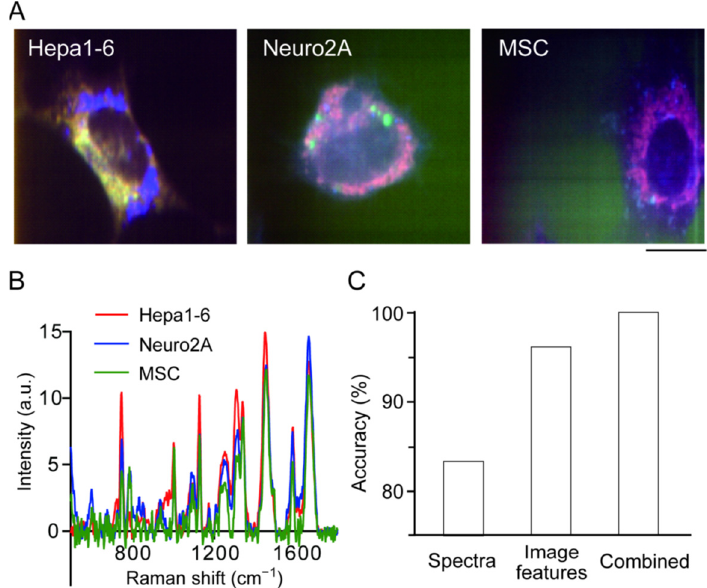
Figure 3. Cell type discrimination using image feature of Raman image. ( A ) Raman image of Hepa1-6 cells (left), Neuro2A cells (middle) and mesenchymal stem cells (MSC) (right). Scale bar, 10 μ m. ( B ) Averaged Raman spectra of Hepa1-6 cells (red), Neuro2A cells (blue) and MSC (green). ( C ) Accuracy of cell type discrimination using Raman spectra (left), image features (middle) and both (right). Reproduction from reference [47].